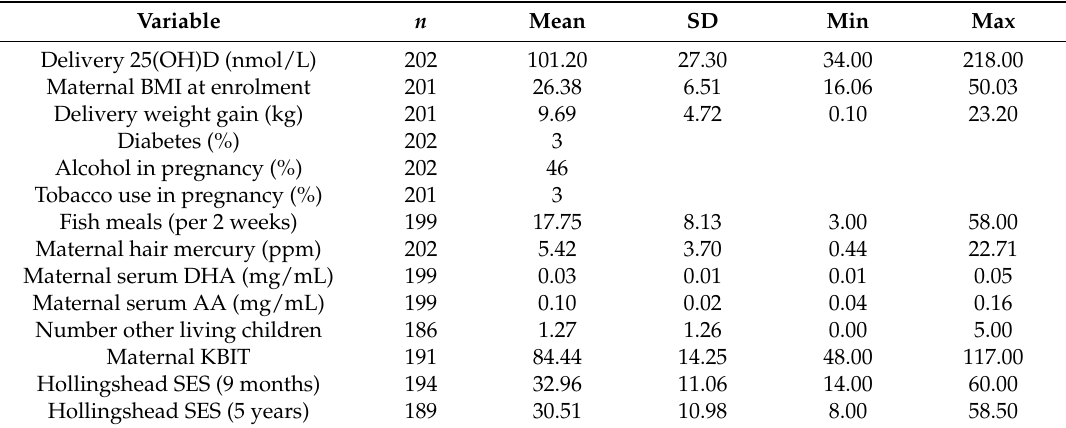
Table 1. Maternal mean, SD, and range for demographic and 25(OH)D measures 1 .